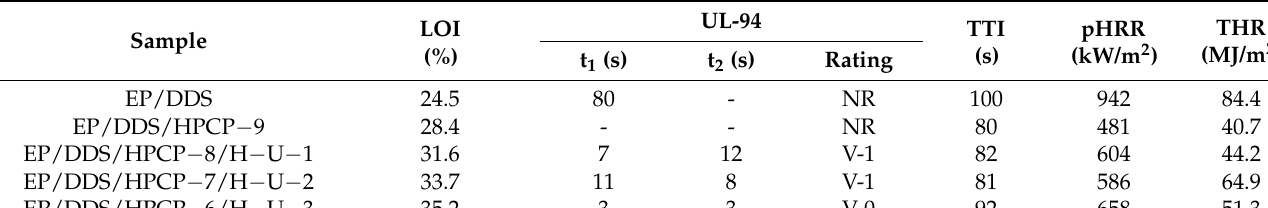
Table 4. Combustion data of EP samples.